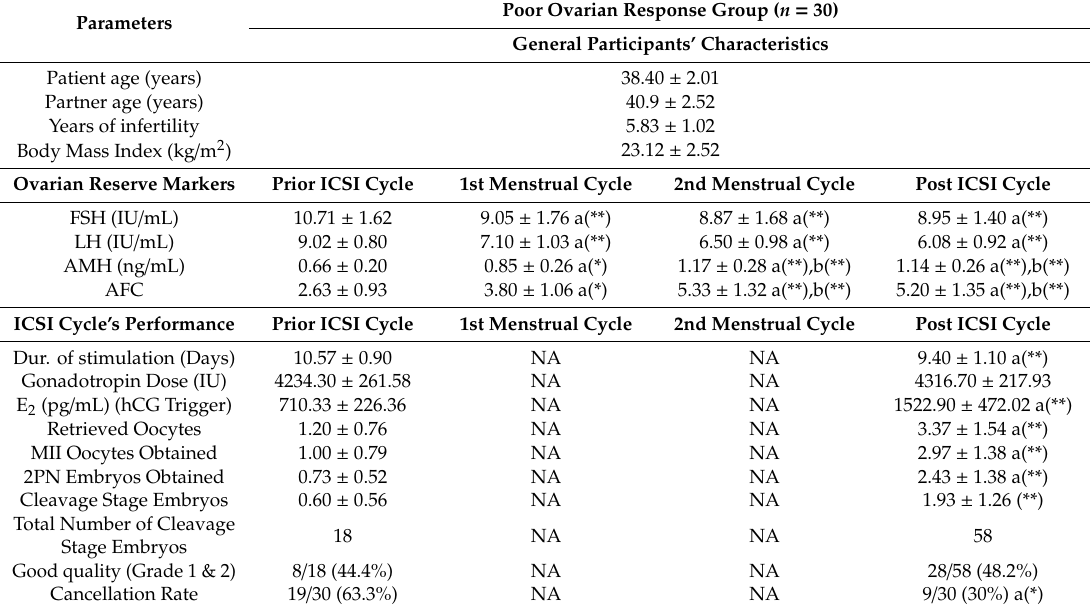
Table 2. Descriptive statistics indicating participants’ general characteristics and respective performance prior to and following PRP treatment in the Poor Ovarian Response pilot